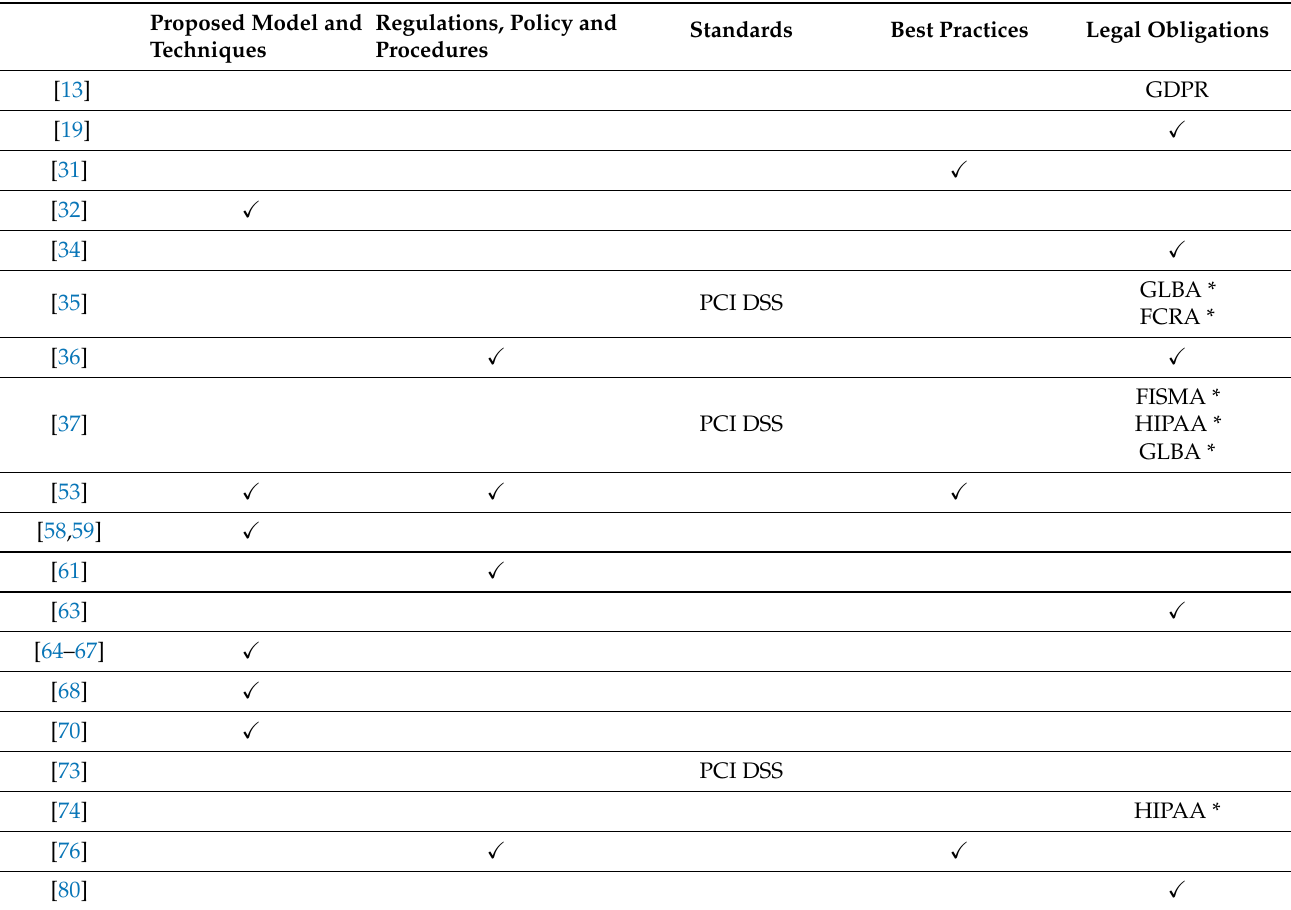
Table 6. Table presents various preventive measures focused in the literature. Well known interna- tional standards or regulations are scribed, whereas (cid:51) is used for local or national